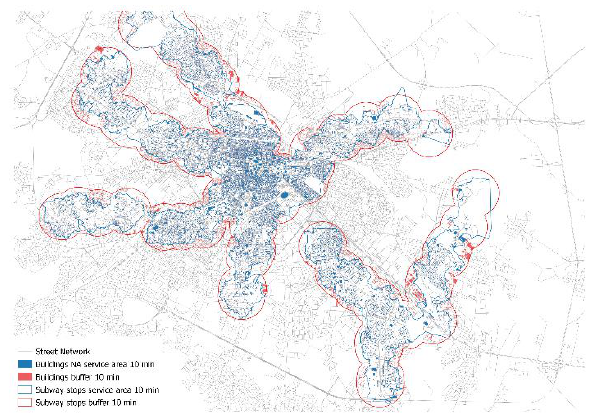
Figure 8. Comparison of accuracy of included buildings in the isochrone impedance in Buffer and Network analysis.